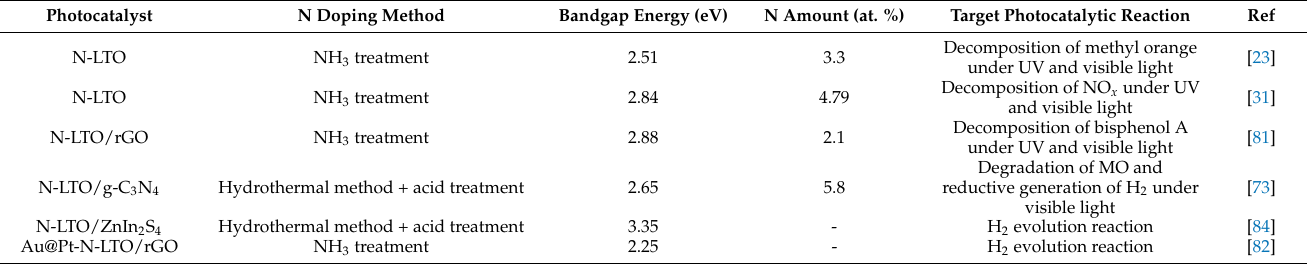
Table 1. Summary of the N-doped La 2 Ti 2 O 7 (N-LTO) and its composites for photocatalytic based